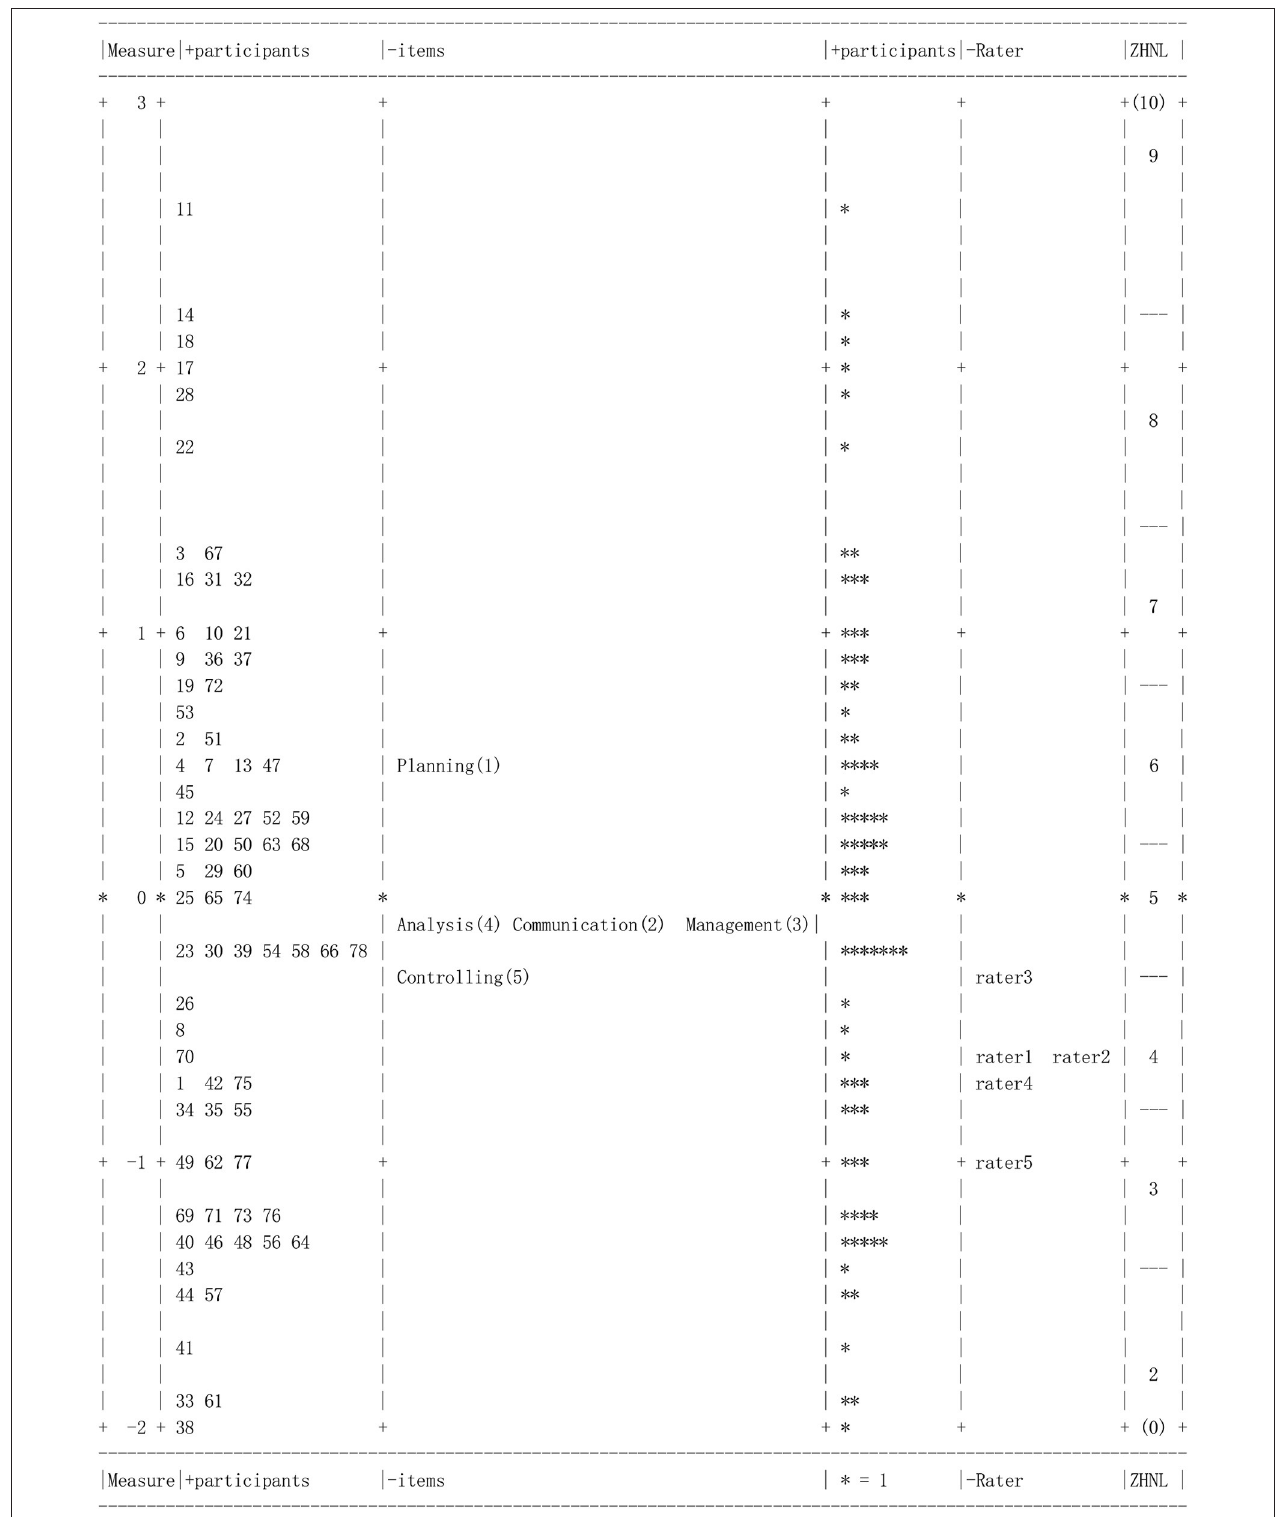
FIGURE 1 | Variable map of all